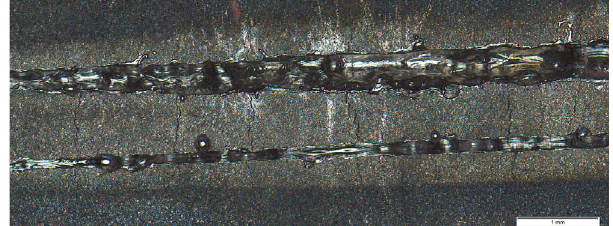
FIG. 1. Damage in the beam-facing surface of a W collimator after irradiation by separate beam aborts at 7-GeV, 100-mA stored current, yielding energy deposition of 2 – 3